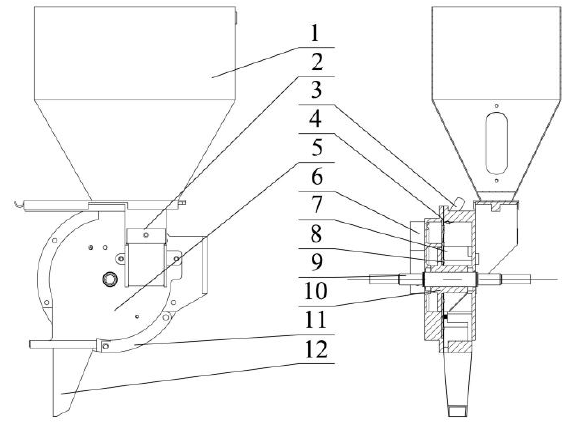
Figure 1. Schematic diagram of the overall structure of pneumatic single seed metering device for coated rice: ( 1 ) seed box; ( 2 ) seed box connector; ( 3 ) seed cleaning mechanism; ( 4 ) sealing ring; ( 5 ) seed chamber shell; ( 6 ) suction chamber shell; ( 7 ) baffle; ( 8 ) sucking plate; ( 9 ) shaft; ( 10 ) flange; ( 11 ) seed unloading device; ( 12 ) seed tube.